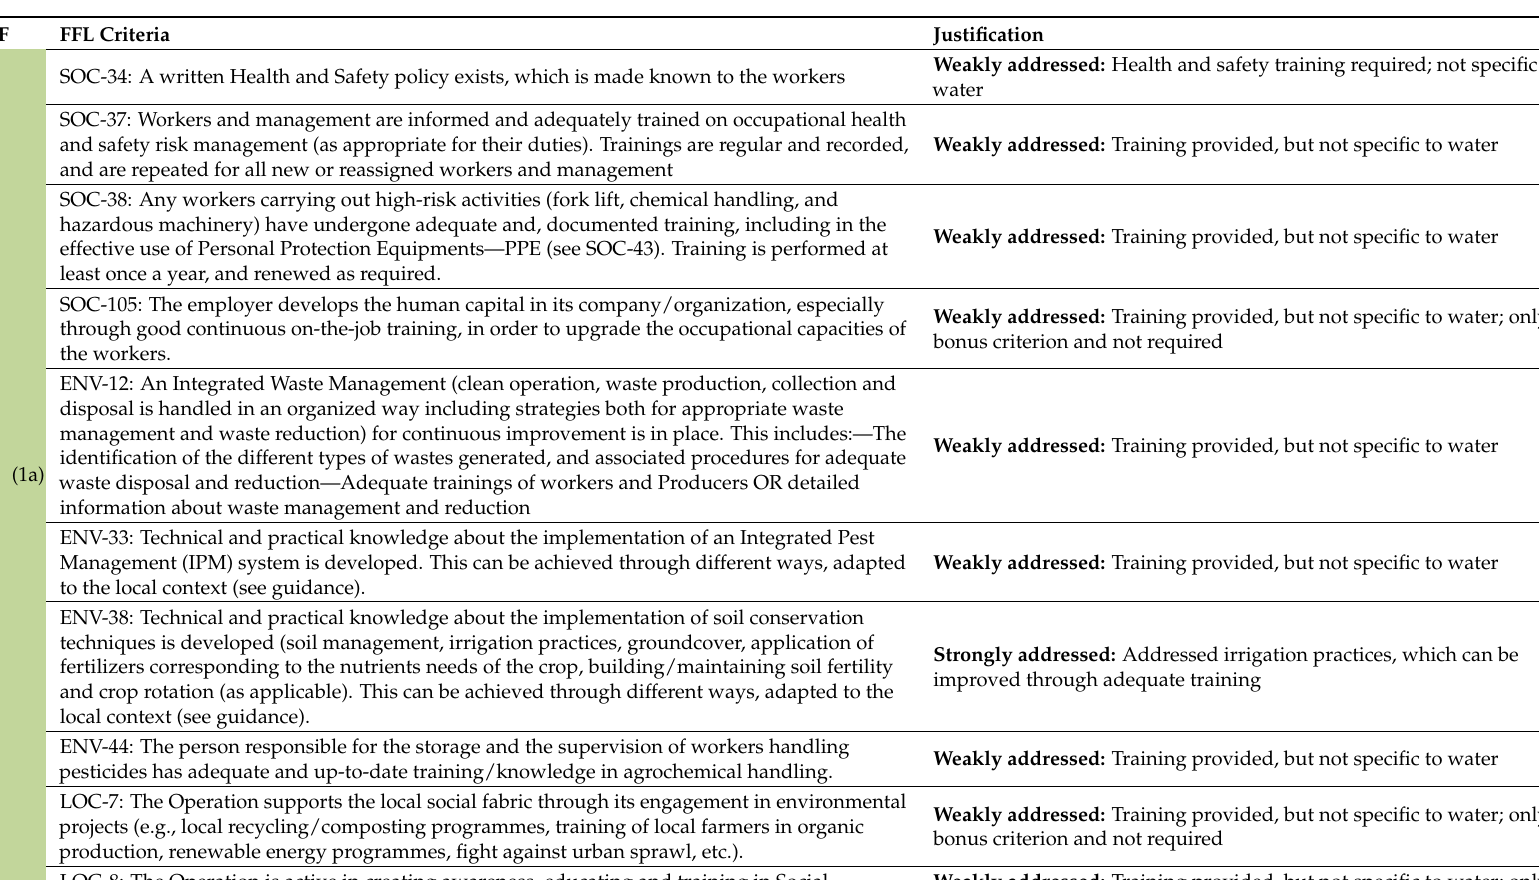
Table A5. Fair for